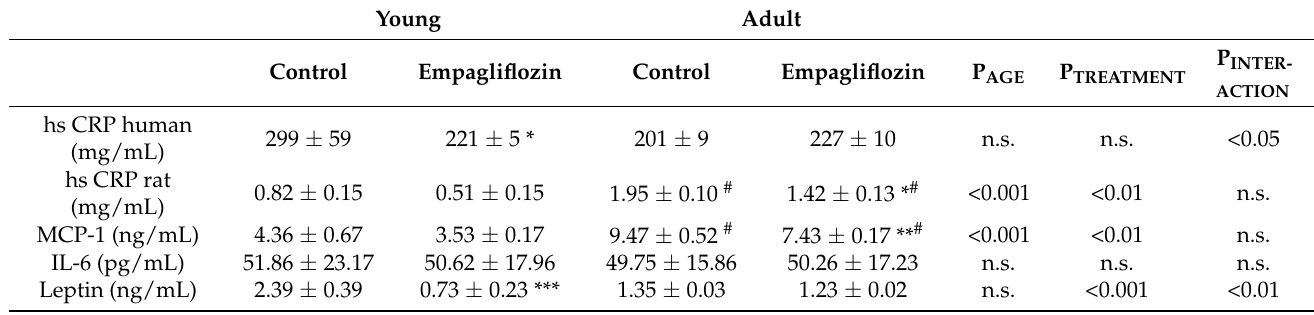
Table 4. Inflammatory parameters in serum in experimental groups at the end of the study.